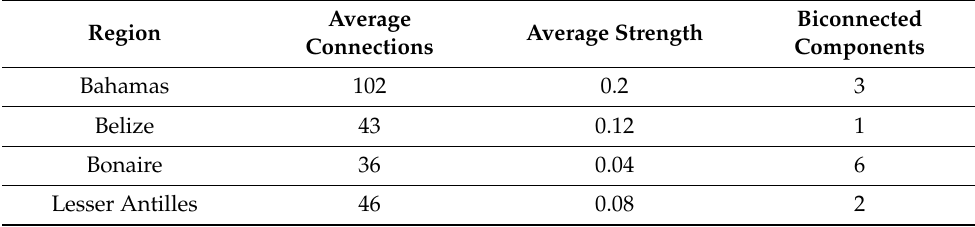
Table 2. Descriptive metrics of global connectivity for the four study regions. Average connections and strength describe the mean number of connections per site and mean flow of larvae between sites, respectively. Biconnected components refer to clusters which are connected together in two or more simple pathways. Biconnected components combine together to form the global network; therefore, fewer biconnected components suggests a more cohesive regional connectivity